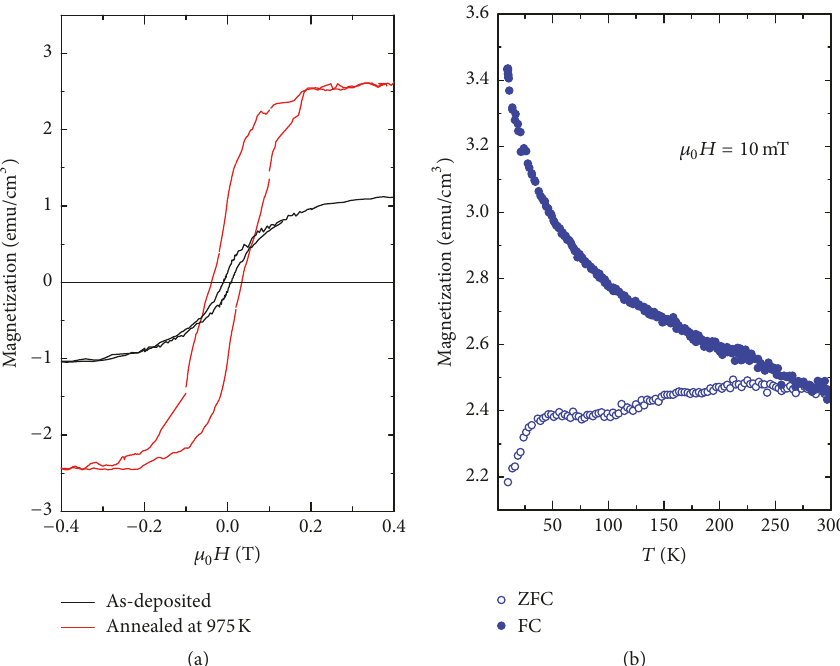
Figure 2: (a) Room temperature hysteresis loops for an as-deposited (black line) and annealed (red line) Co-doped ITO. (b) Zero-field cooled (open blue circles) and field-cooled (solid blue circles) magnetization versus temperature curves for the annealed Co-doped ITO film recorded in an applied magnetic field of 10mT.